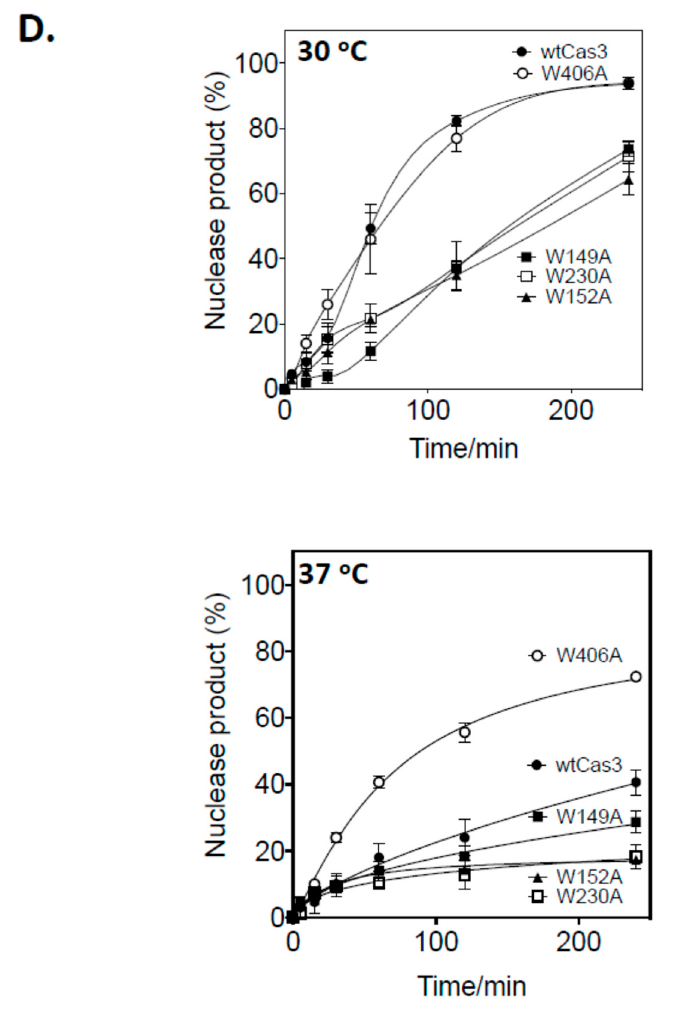
Figure 2. Structural positioning of two invariant tryptophan residues at the interface of Cas3 HD and RecA1 domains—a key role in Cas3 nuclease function for Trp-406. ( A ) Cartoon representation of Cas3 protein with amino acid residues indicated for the nuclease (HD) and Walker B ATPase active sites using numbering from the E. coli protein. Highlighted in the foreground is the region detailed in the results, located at the interface of HD and RecA1 domains (‘iHDA1’) and including the ssDNA binding helicase motifs Ib and Ic. ( B ) E. coli Cas3 structure deduced from T. fusca Cas3 (PDB: 4QQW) and T. terrenum (PDB: 4Q2C) (27,35) highlighting the tryptophan residue W406 (labelled) and the passage of ssDNA (tan cord). Cas3 regions are denoted as follows in the same way as in part A: HD (orchid), RecA1 (green), RecA2 (orange), an interdomain linker helix (purple) and the CTD (blue). Grey spheres indicate the HD nuclease active site residues. ( C ) Sequence alignment highlighting conservation of residues Trp-406 and Trp-230 in Escherichia coli K-12 (Eco) with the structurally determined Cas3 proteins from T. fusca (Tfu) and T. terrenum (Tter) proteins. Protein sequences were aligned using Clustal Omega and results were exported via Lasergene 17. ( D ) Nuclease activity of Cas3 and mutants (56 nM) measured on the DNA fork substrate (20 nM). Samples were collected at 0, 5, 15, 30, 60, 120 and 240 min. Reactions were carried out in triplicate at 30 ◦ C or 37 ◦ C as indicated, and data points show standard errors from the